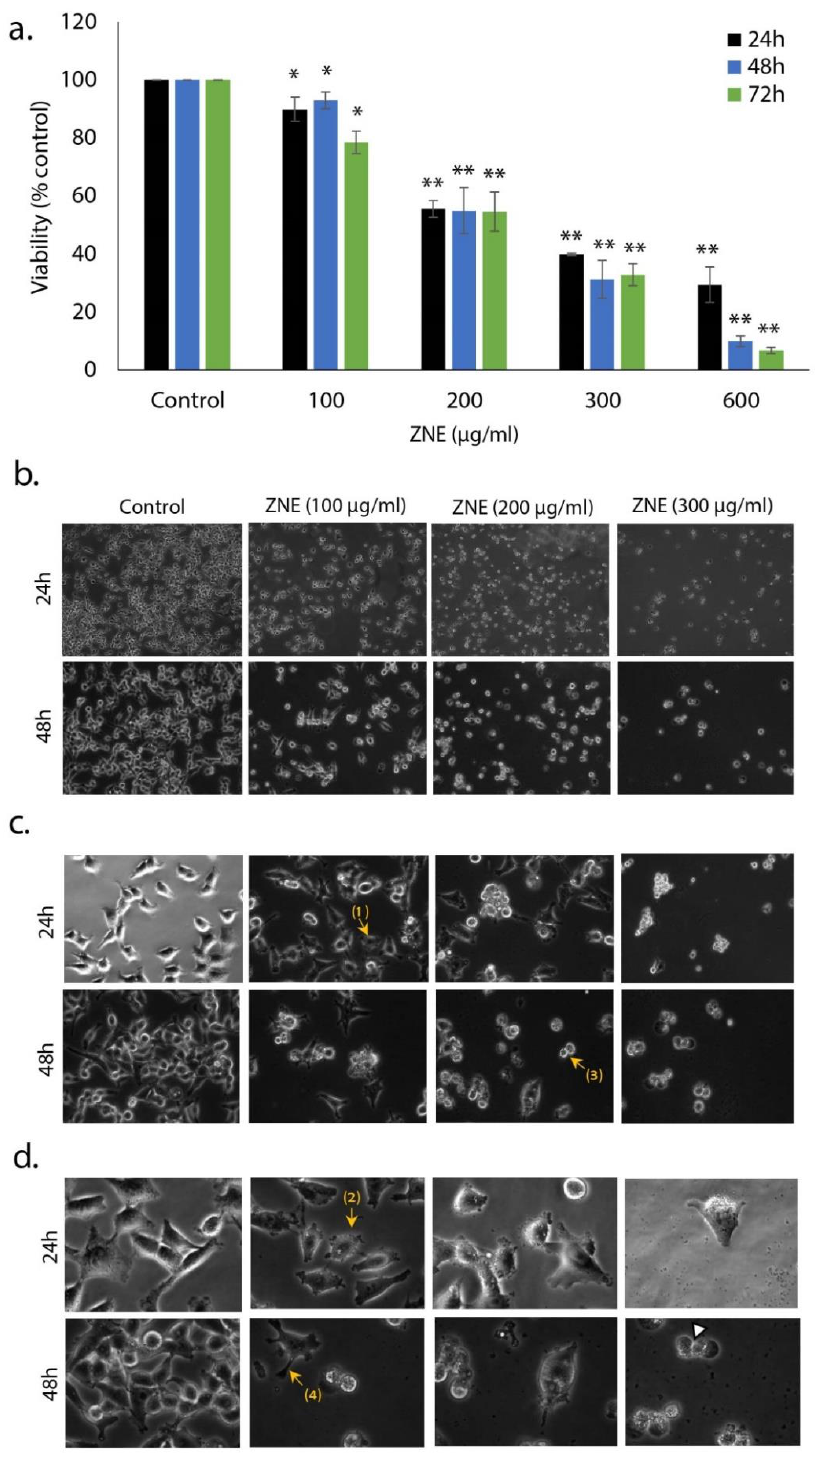
Figure 1. Inhibition of cellular viability by Ziziphus nummularia ethanolic extract. ( a ) Capan-2 cancer cells were treated with and without the indicated concentrations of Ziziphus nummularia ethanolic extract (ZNE) for 24, 48, and 72 h. Cell viability was carried using the metabolic-dye-based MTT assay, as described in Materials and Methods. Data represent the mean of three independent experiments performed in triplicate. Morphological changes were observed at magnifications of 4× ( b ), 10× ( c ), or 40× ( d ). Arrows show (1) cell shrinkage, (2) membrane blebbing, (3) apoptotic bodies, and (4) echinoid spikes. * denotes p < 0.05, and ** p < 0.01.